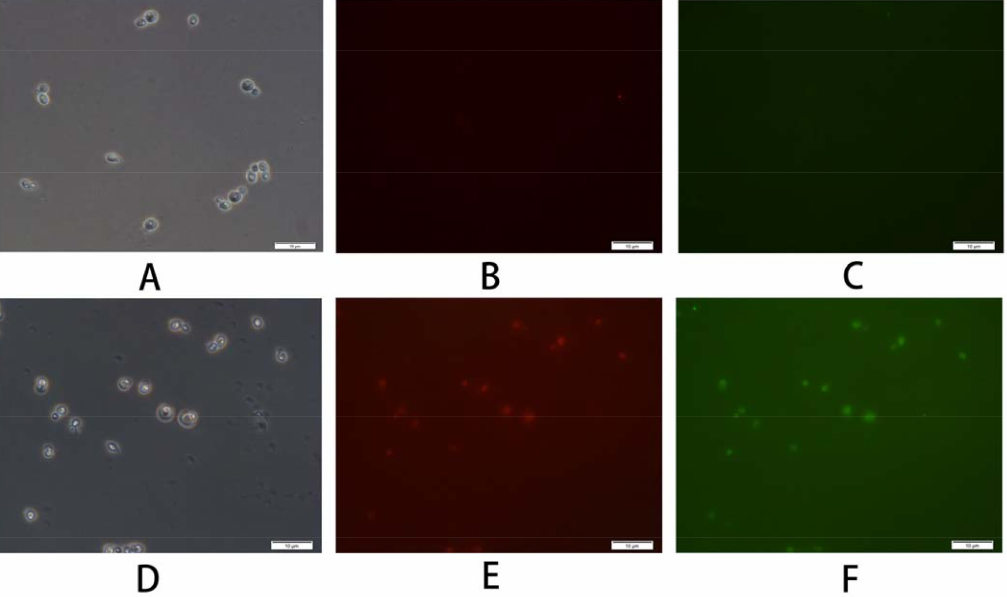
Figure 6. PI and Annexin V-FITC staining of the Massoia lactone NEs untreated pathogenic yeast cells ( A – C ) and PI staining of the Massoia lactone NEs treated pathogenic yeast cells ( D – F ). The photos ( A , D ) were taken under the normal light and the photos ( B , C , E , F ) were taken under UV light. The Bar = 10 µ